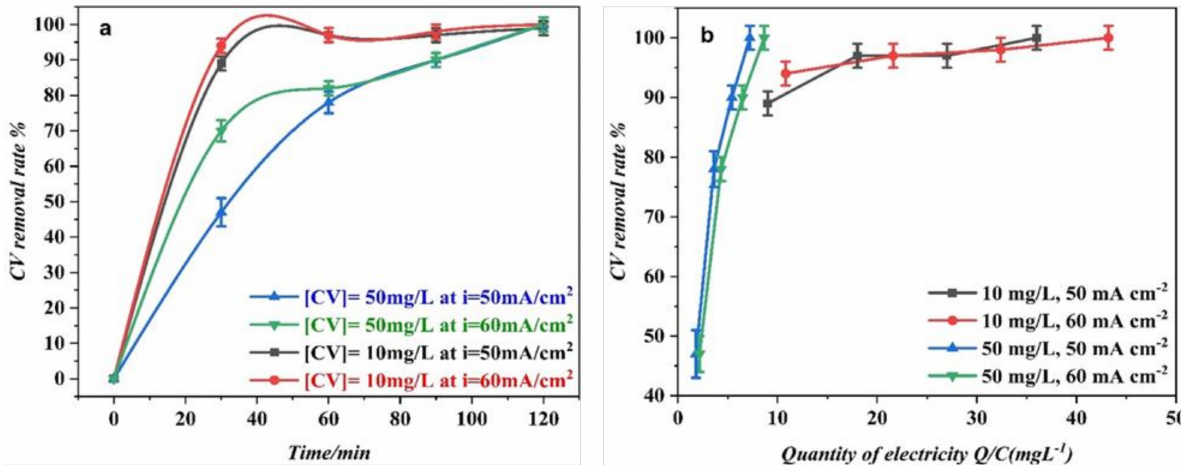
Figure 8. CV abatement rate as function of ( a ) time and ( b ) electrical charge in C/(mgL − 1 ). [CV] 0 = 10 mg L − 1 , initial pH = 7, i = 50–60 mA cm − 2 and temperature = 25 ◦ C.